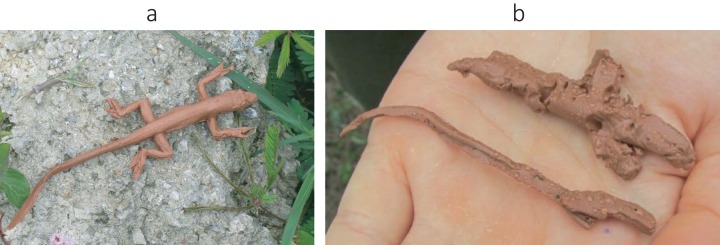
Clay model of a brown anole used for estimating predation pressure.Photograph of a clay Anolis model used for estimating predation pressure: (A) an intact model; (B) a recollected model with predation marks. Picture by Tess Driessens.